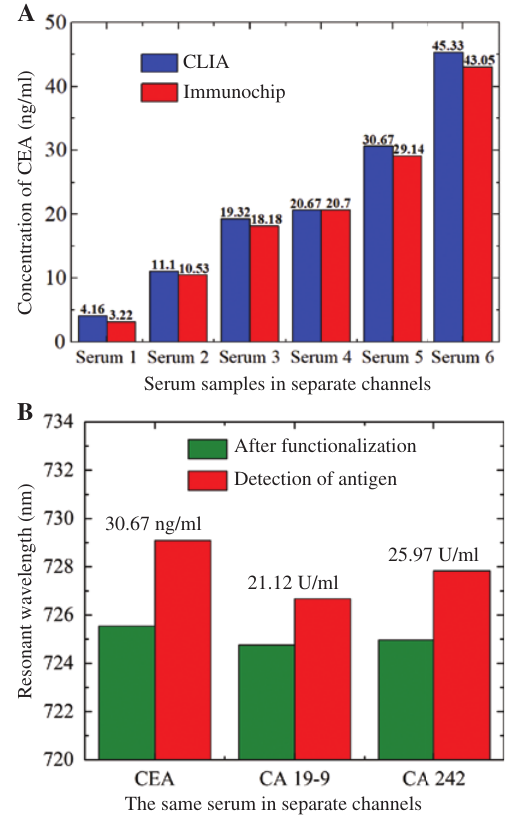
Figure 6: Detection of human serums. (A) CEA detection results of serum samples from six individuals using the plasmonic immunochip, compared with using CLIA. (B) Concurrent sensing of three tumor markers in